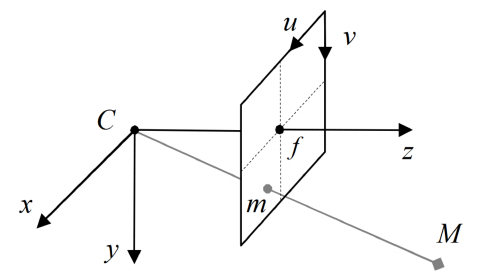
Figure 1. Pinhole camera model camera matrix K containing the focal length f and the principal